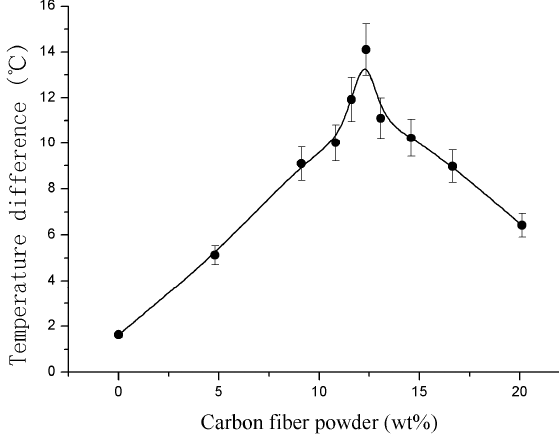
Figure 3. The relationship between the coating CF mass fraction and temperature.